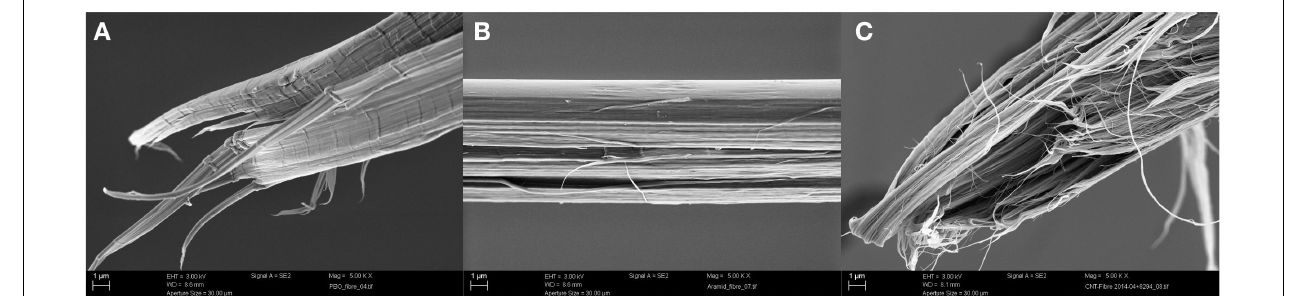
FIGURE 1 | Fracture surfaces of PBO (A), AR (B), and CNT (C) fibers .